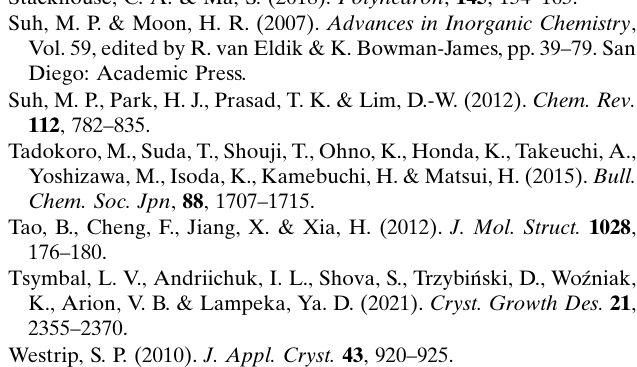
Crystal data Chemical formula